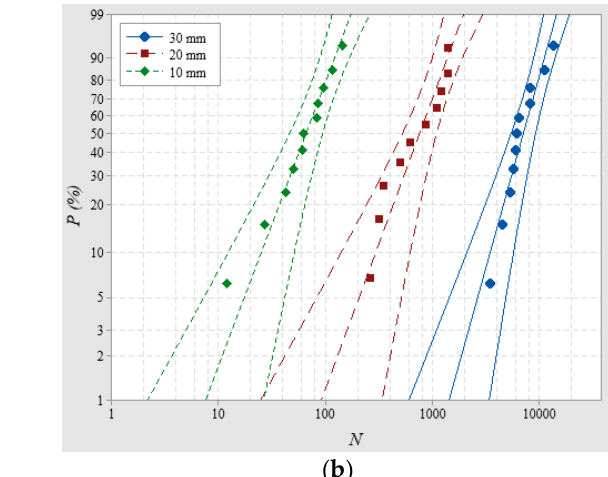
Figure 5. SILs vary with ( a ) different materials and ( b ) different thicknesses.